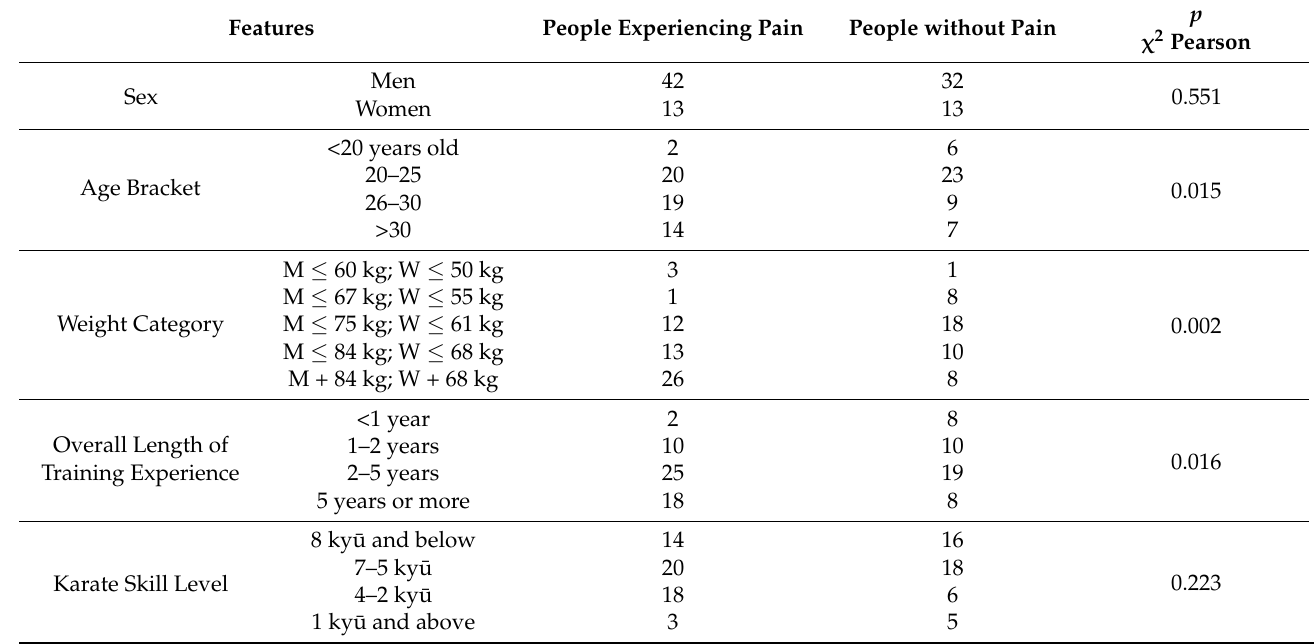
Table 2. Occurrence of low back pain according to selected